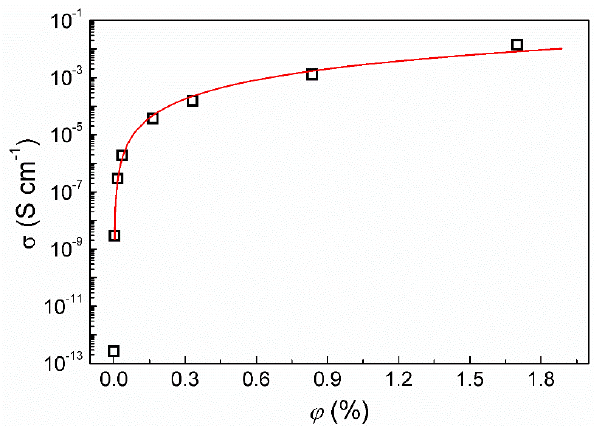
Figure 7. The dependence of the DC conductivity on the volume fraction for the various coPA/MXene composite thin films.